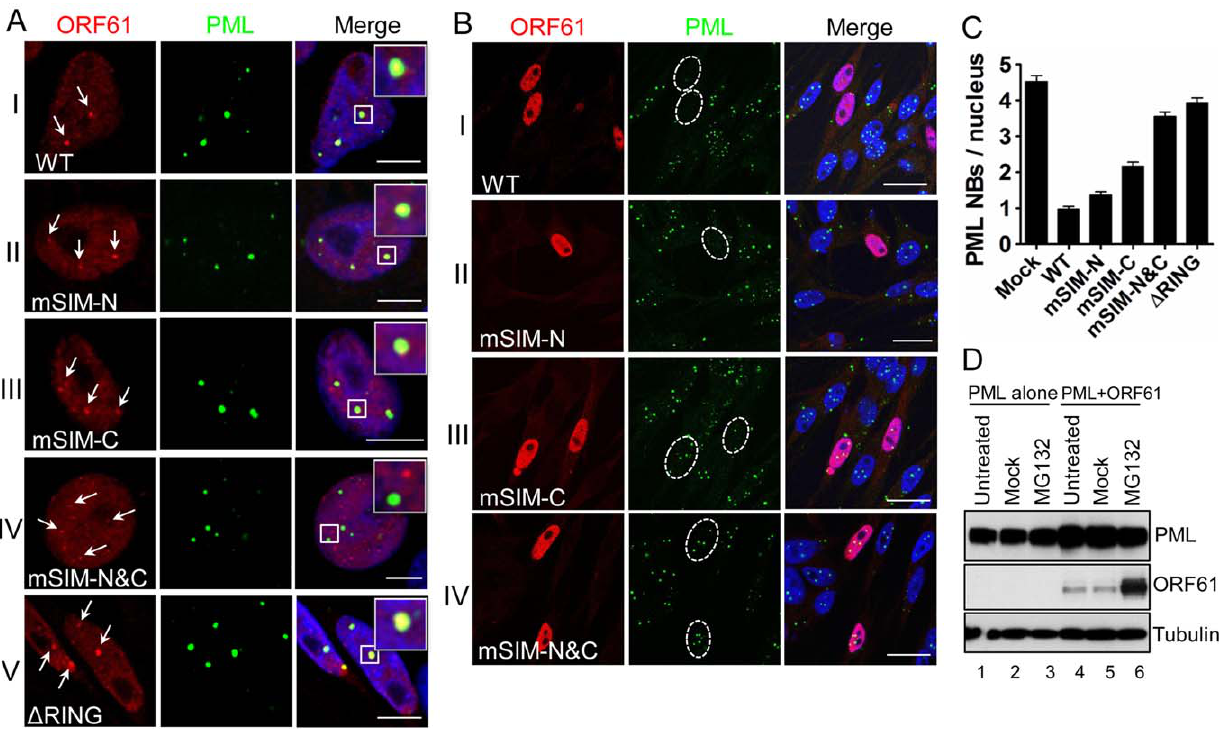
Figure 2. ORF61 SIMs are essential for ORF61 association with PML NBs and PML NB disruption in transfected cells. (A) Confocal microscopy of ORF61-, SIM mutants-, or n RING-transfected melanoma cells that were stained for ORF61 (red), PML (green), and nuclei (blue). ORF61- positive puncta in cells expressing low level of ORF61 wild-type and mutant proteins are indicated by white arrows and their associations with PML NBs are shown. The insets are zoom-in images of the white square area. Scale bars: 5 m m. (B) Confocal microscopy of ORF61- or SIM mutant- transfected melanoma cells that were stained for ORF61 (red), PML (green), and nuclei (blue). Nuclei with abundant expression of ORF61 or SIM mutant proteins are outlined by dashed ovals. Scale bars: 20 m m. (C) PML NB frequencies (mean 6 SEM) in cells expressing abundant ORF61, n RING, or SIM mutant proteins (Mock, N=245; WT, N=224; mSIM-N, N=234; mSIM-C, N=237; mSIM-N&C, N=238; D RING, N=201). (D) The effect of ORF61 on the PML IV protein level. Melanoma cells transfected with PML IV expressing plasmid alone or together with pcDNA-ORF61 were treated with 10 m M MG132 for 6 h at 24 h post-transfection. Western blots with ORF61, PML, and tubulin antibodies are shown.